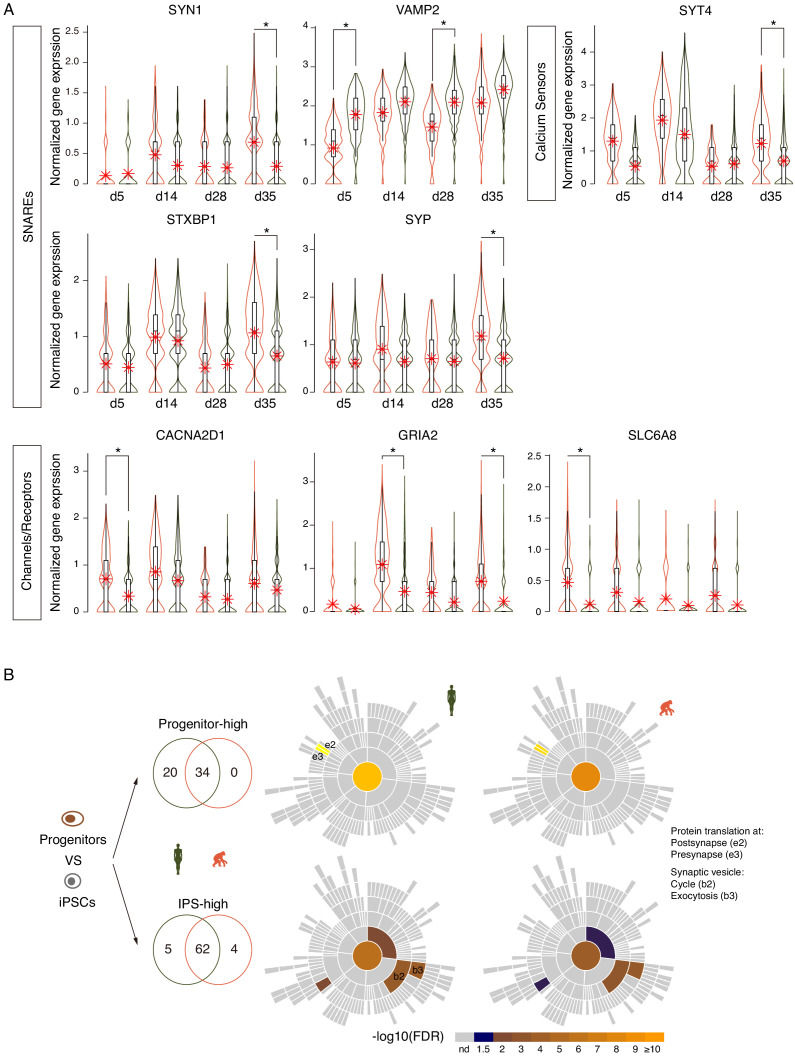
Transcriptional neoteny of synaptic genes in human iNs.(A) Synaptic genes are differentially expressed in ape and human iNs. Expression over time of SNARE proteins (synapsin (SYN1), VAMP2, STXBP1, and the syntaxin-binding protein SYP), calcium sensors for regulated secretion (Synaptotagmin, SYT4), and channels/receptors (the voltage-operated calcium channel’s subunit CACNA2D1, the glutamate receptor’s subunits GRIA2, and the creatine transporter SLC6A8). (B) SynGO enrichment analysis with significantly differentially expressed genes between NP and iPS cells of the same species. Left panel, higher expressed genes in human and ape NP (top panel) compared with corresponding iPSCs (bottom panel). Right panel, sunburst plots of enriched synaptic GO terms in human and ape NP and iPS cells. The log10-transformed FDR-corrected p value per ontology term is visualized for BP. Note that the bottom BP sunburst plots are aligned with the top-right one.